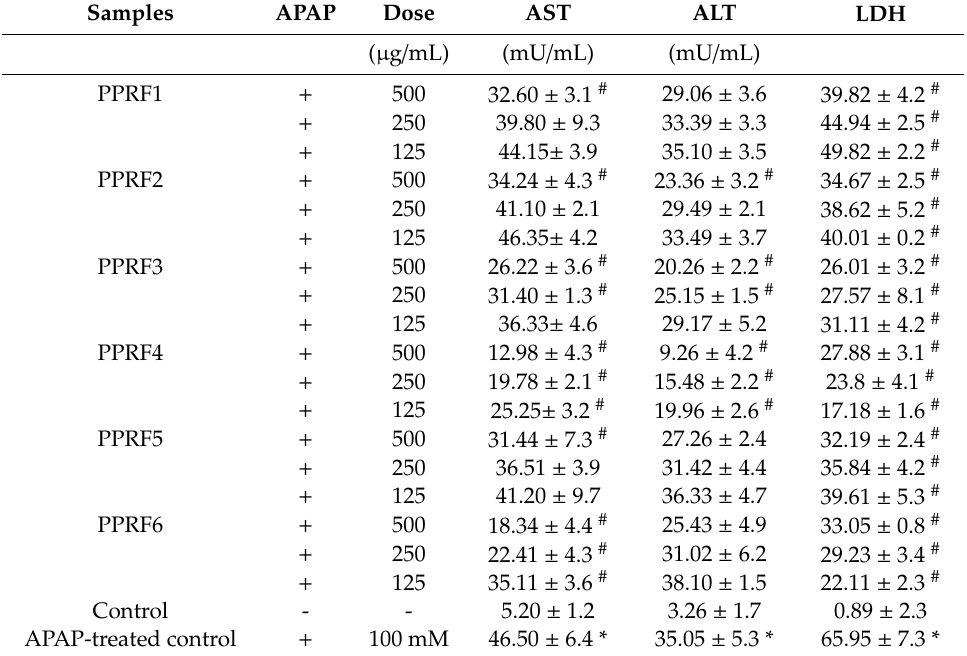
Table 4. Protective e ff ect of polyphenolic-rich fractions of L. tetragona on APAP-Induced hepatotoxicity in HepG2 cells.